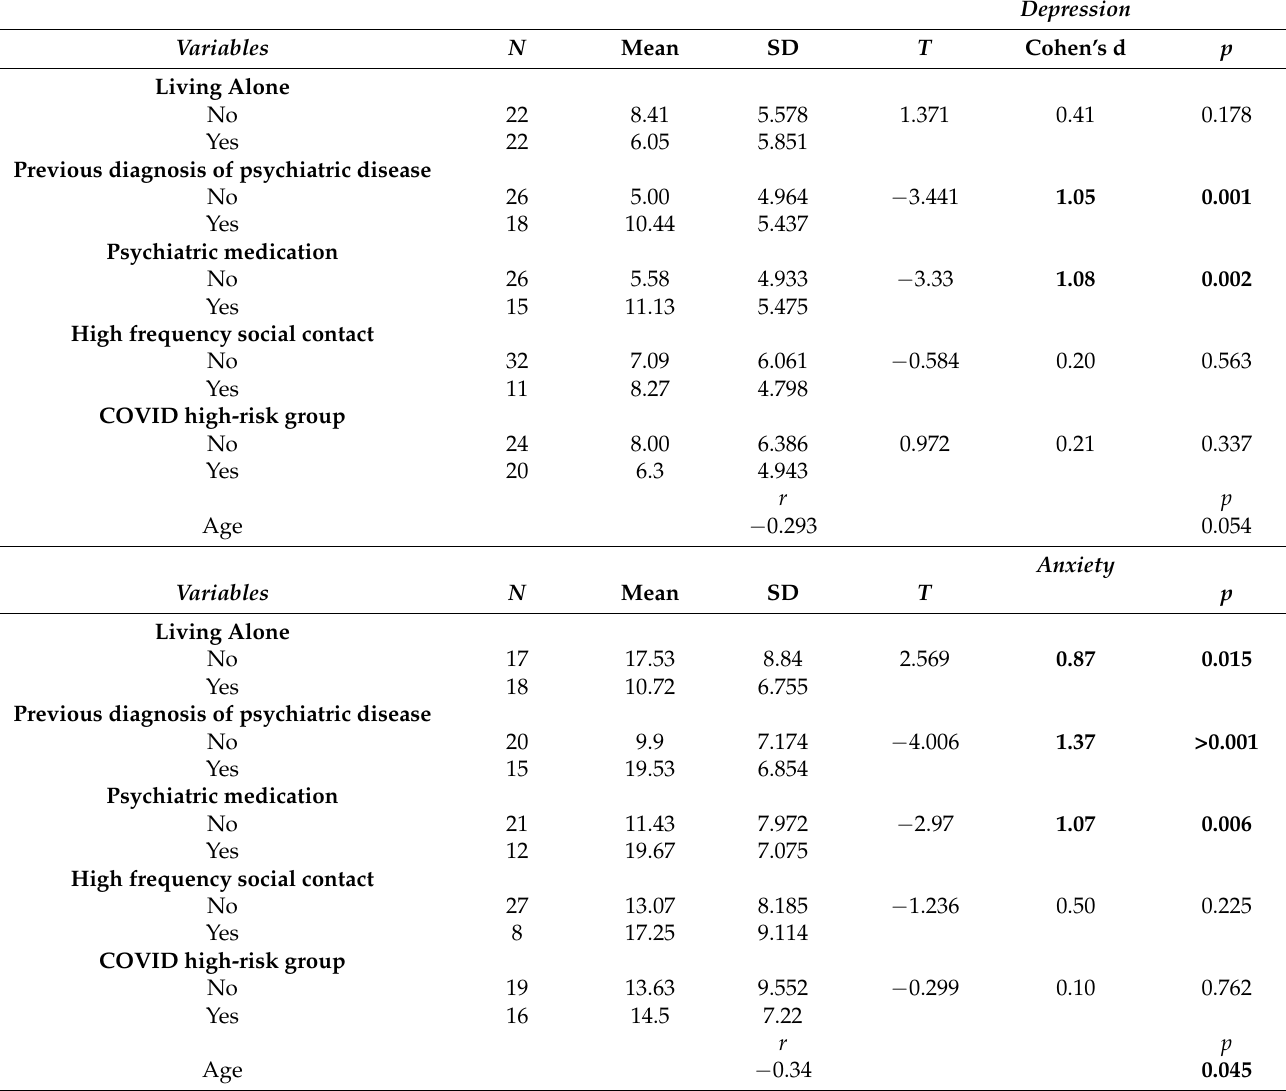
Table 2. Associations between sociodemographic variables and mental health status. Differences in mean levels between categories were assessed via t -test. Individuals living alone reported higher anxiety symptoms than those living with others. Individuals with a prediagnosed psychiatric disorder reported more anxiety and depressive symptoms than callers without. Callers currently taking psychiatric medications reported significantly more depressive and anxiety symptoms. There were no differences among those at higher risk for COVID-19 or those engaging in frequent social interactions. Age was negatively correlated with higher levels of depressive and anxiety symptoms. Significant p values ( p < 0.05) are shown in